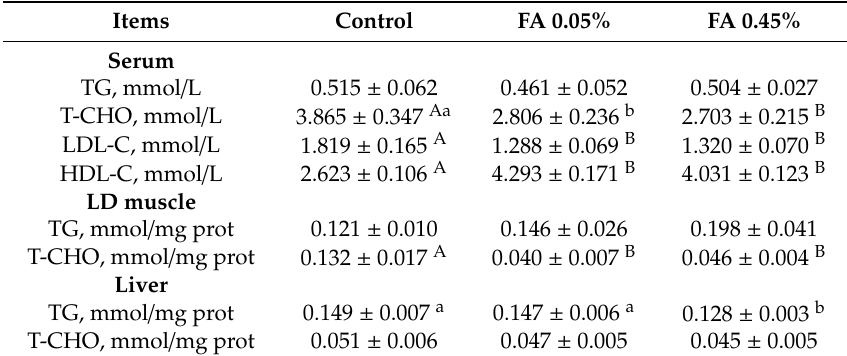
Table 2. Lipid profiles of serum, LD muscle, and